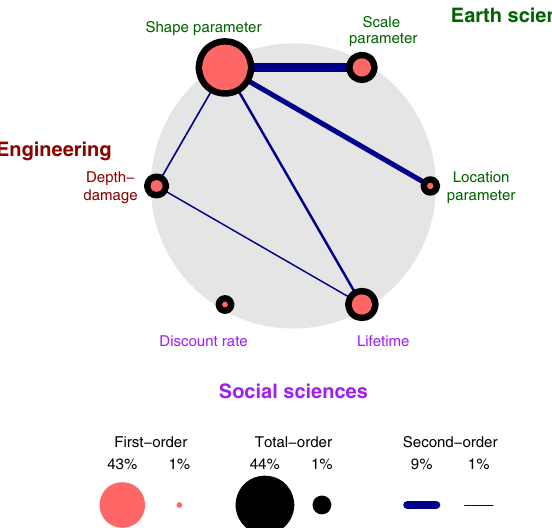
Fig. 5 Sensitivity analysis. Sensitivity of lifetime expected damages for a hypothetical (1500 ft 2 with worth of $300 K) house in Selinsgrove, PA to the considered uncertainty sources. Results are from a global sensitivity analysis. Salmon circles are proportional to the individual sensitivity of each source. Lines ’ thicknesses are proportional to the relative importance of the interactions between the two sources. The black circle diameter is an indicator of both. Indices that are not signi fi cant at a 95% con fi dence level are not